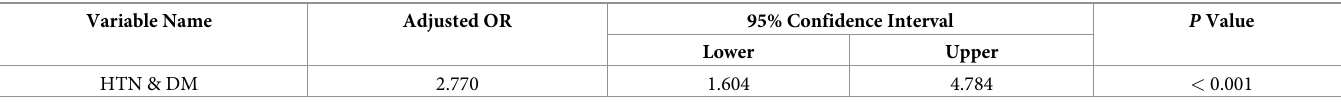
Table 4. Univariate logistic regression for combination HTN & DM with mortality